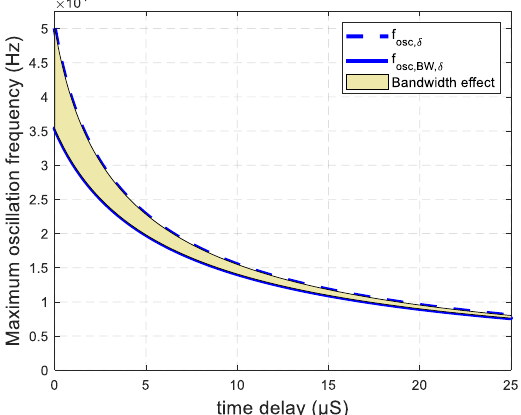
Figure 6. Evolution of the maximum oscillation frequency under PSSOCC control, as a function of the time delay, for a natural frequency f o of 50 kHz, a unitary damping factor ξ , a time constant τ 1 of 3.6 ms and a current sensor bandwidth of 100 kHz.